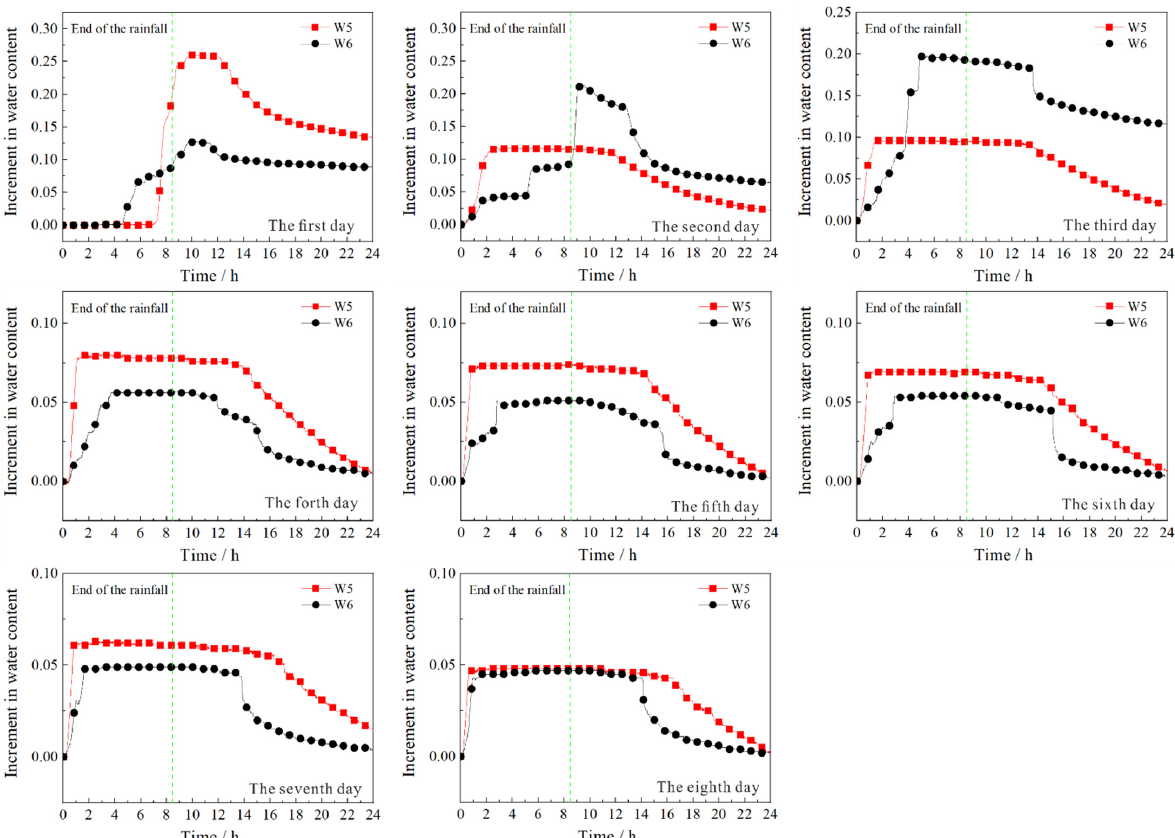
Figure 5. Variation of water content in the following days, from the first to the eighth (H2 = 0.8 m).